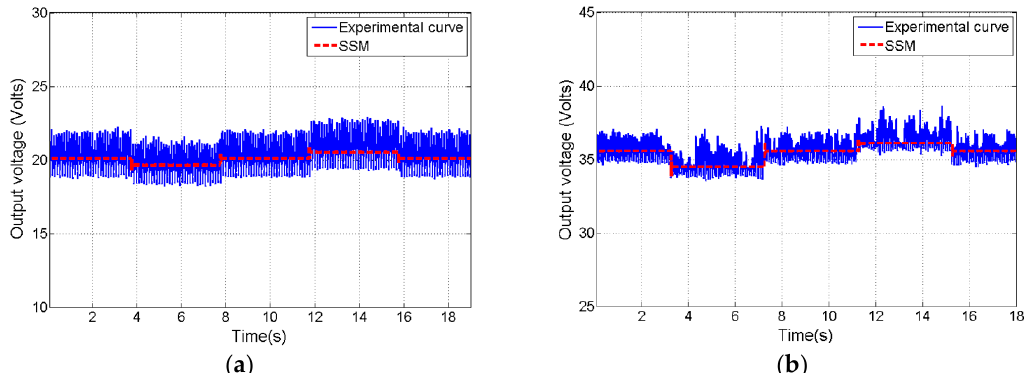
Figure 5. Experimental and SSM output voltages curves with 4% perturbation width: ( a ) around thirty percent and ( b ) around sixty percent DRs.